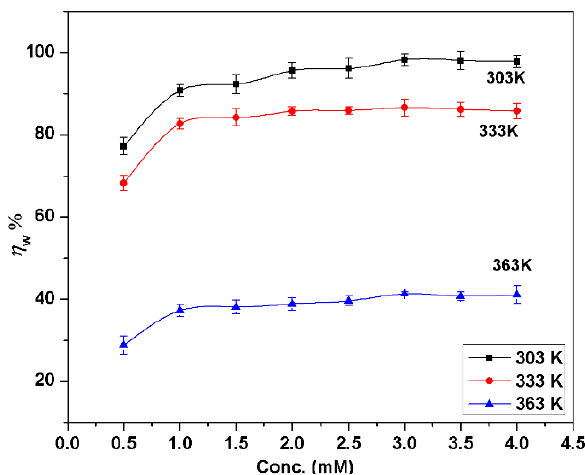
Figure 1. Relationship between inhibition e ffi ciency ( η w ) and concentration of inhibitor in 1 M HCl at di ff erent temperatures using weight loss method with immersion time of 90 min.